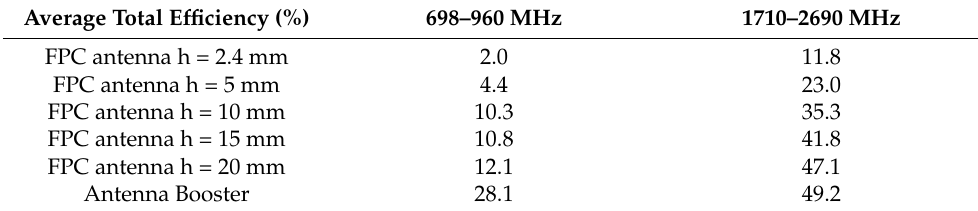
Table 4. Measured total efficiency for the FPC antenna and antenna booster.